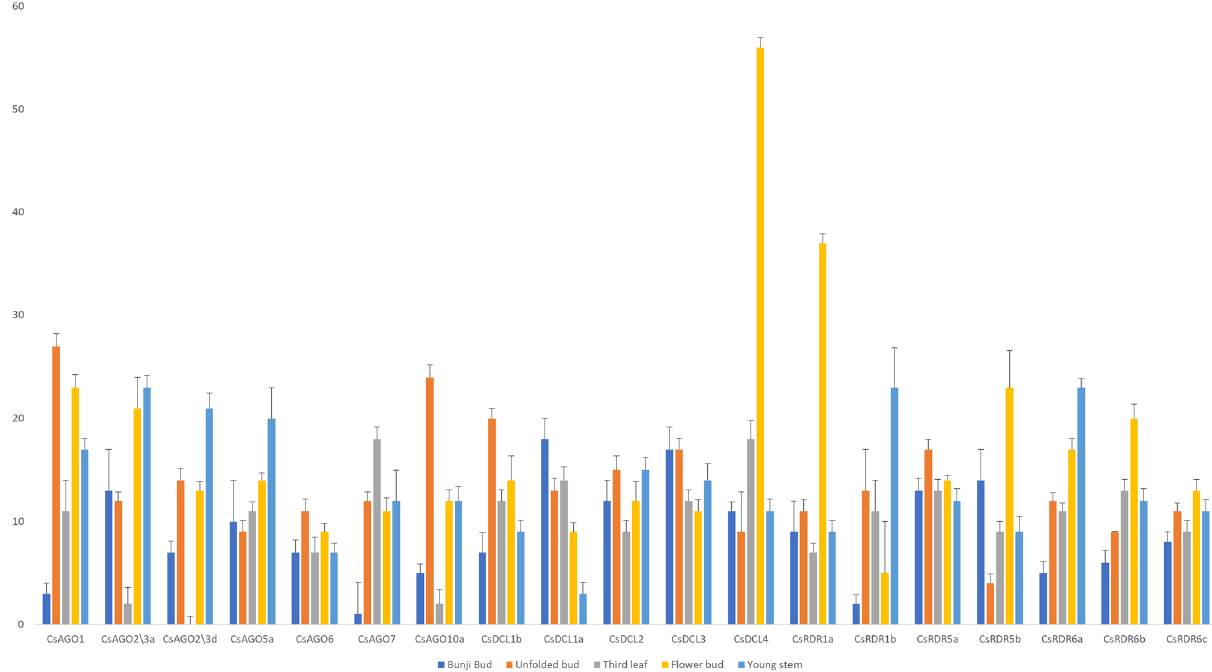
Figure 11. qRT-PCR analysis showing the results of expression pattern of 19 considered genes in different tissues of TV1 cultivar of tea plant. The names of the genes are shown in the x-axis, and y-axis represents the fold changes of expression of the